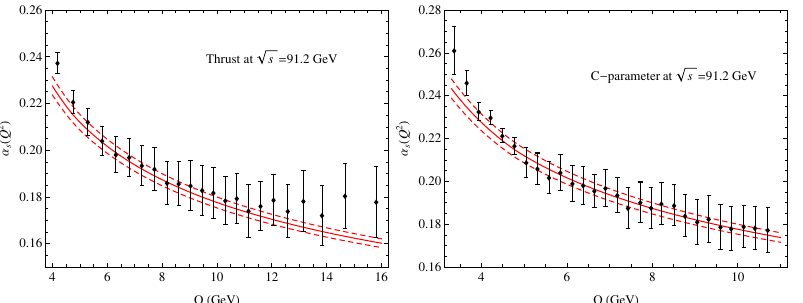
Figure 4. The extracted running coupling α s ( Q 2 ) from the thrust ( T ) and C -parameter ( C ) distribu- tions by comparing the PMC predictions with the ALEPH data [39] measured at a single energy of √ s = 91.2 GeV. As a comparison, the three lines represent the world average